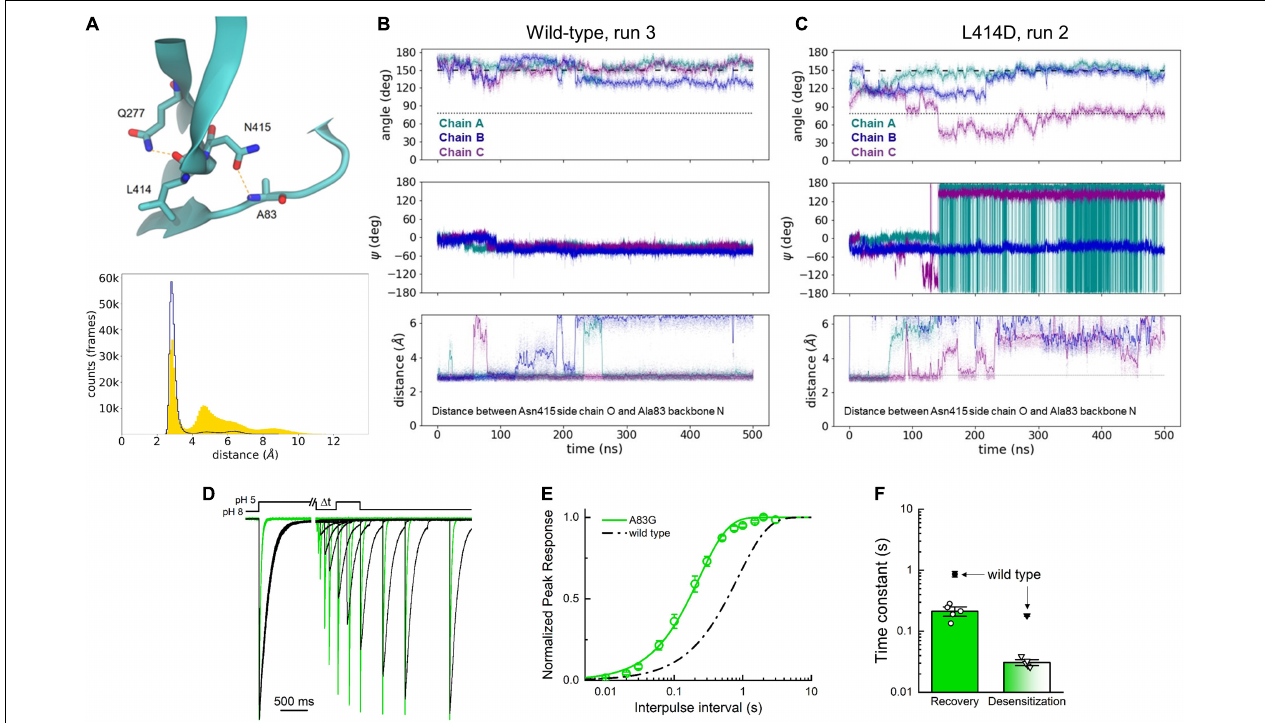
FIGURE 8 | Asn415 and Ala83 interaction may influence desensitized state stability. (A) Depiction of Asn415-Ala83 interaction in the desensitized state (upper) and histogram of distances in wild-type (blue trace) and L414D (yellow area) simulations (lower). (B) Side chain angle (upper), Asn415 psi angle (middle) and distance between Asn415 side chain oxygen atom and Ala83 backbone nitrogen atom (lower) in a stable wild-type simulation. The dotted line illustrates the side chain angle of L414 in the desensitized state structure while the dashed line illustrates the side chain angle in the resting state structure. (C) Same as panel (A) but for an L414D simulation. (D) Example recovery from desensitization experiments for wild-type (black) and A83G (green). (E) Recovery from desensitization curves for wild-type (black) and A83G (green). (F) Summary of recovery (circles) and desensitization (triangles) time constants. Open symbols represent individual patches. Filled symbols represent mean data from Rook et al. (2020). Error bars are